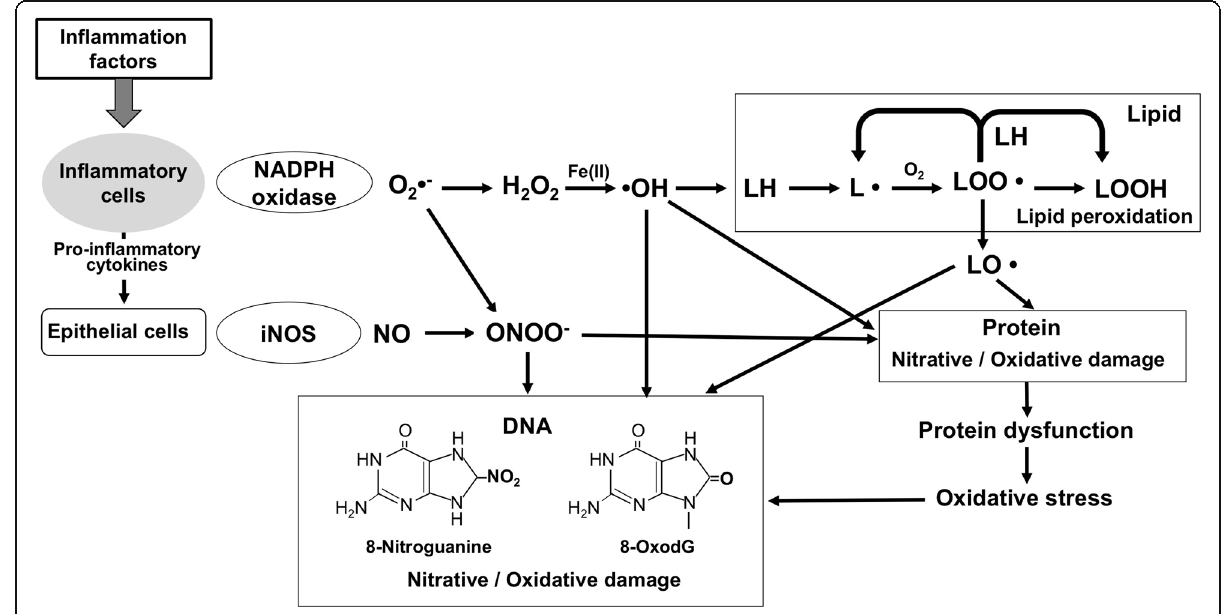
Fig. 1 Biomacromolecule damage by